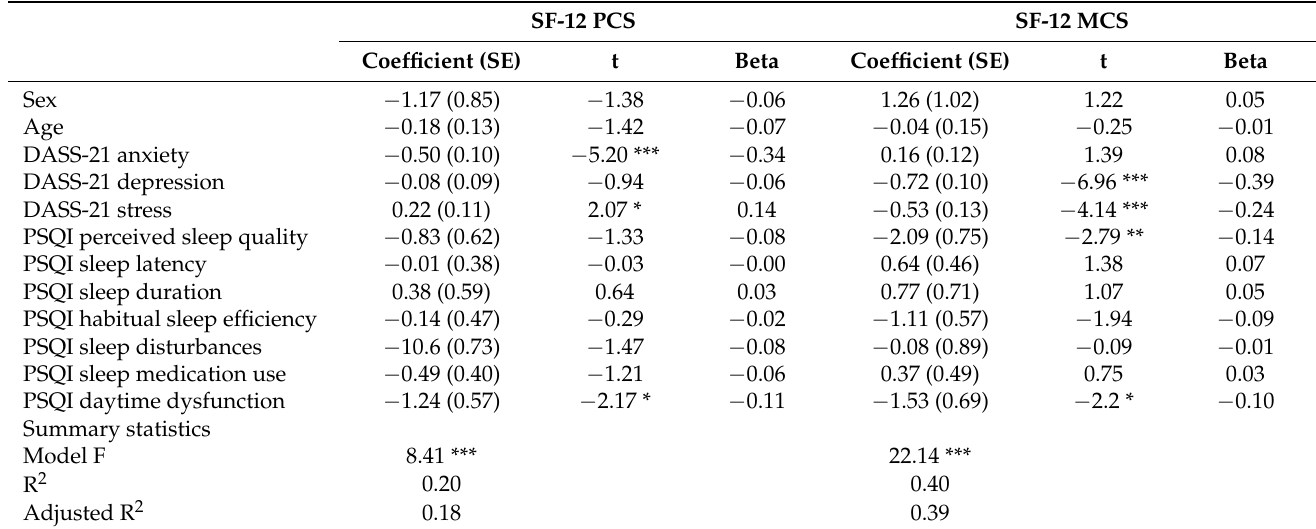
Table 3. Hierarchical multiple regression models (final models) with physical (SF-12 PCS) and mental (SF-12 MCS) health-related quality of life as dependent variables. SF-12 PCS SF-12 MCS t